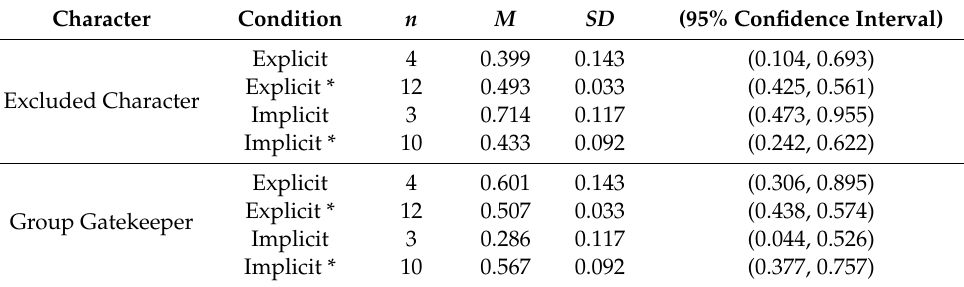
Table 2. Mean proportions of fixations on primary AOI during the end